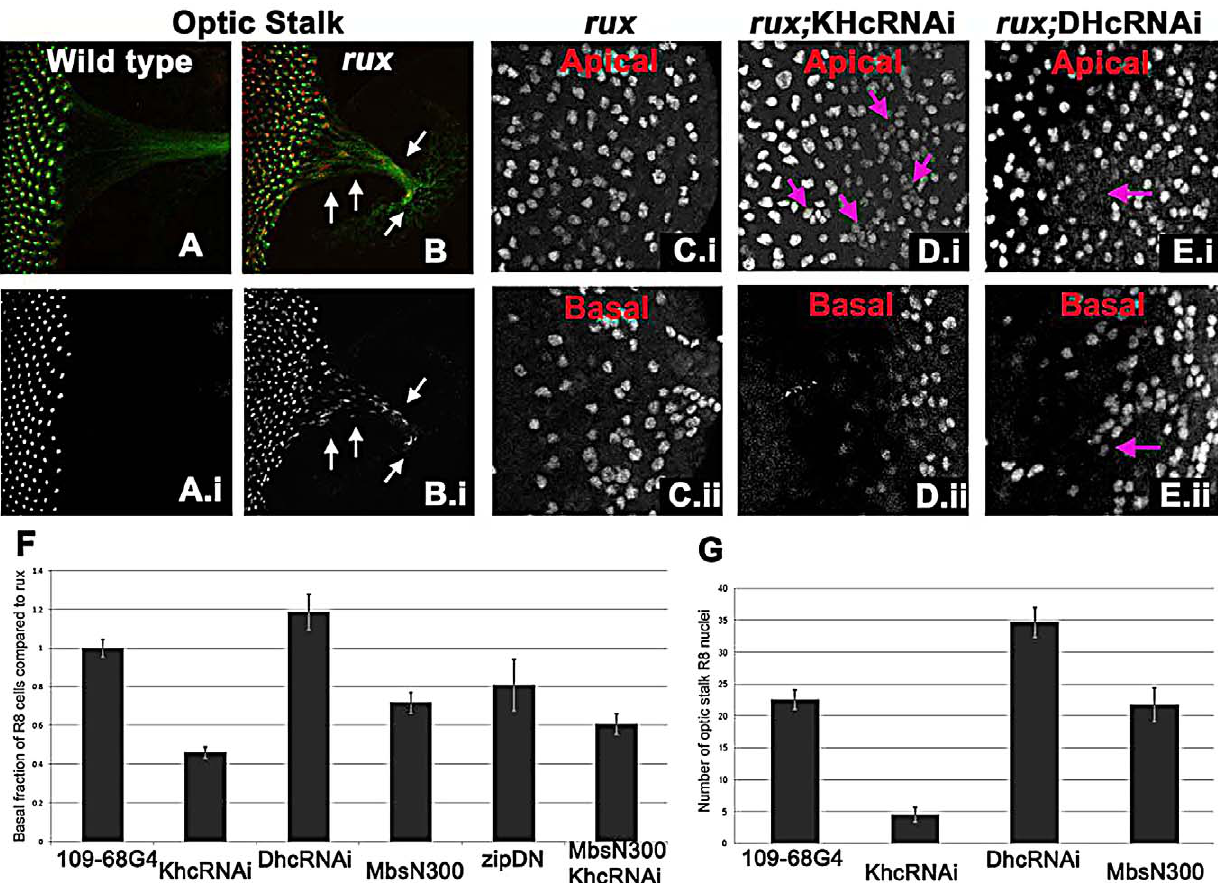
Figure 5. Kinesin and Dynein regulate nuclear position in post mitotic rux R8 cells. (A–B) Wild type (A) and rux (B) eye discs and optic stalks labeled with anti-Sens (red) and anti-Futsch (mAb22C10; green). Arrows showing R8 cells in the optic stalk in rux . (C) R8 cells from the apical (i) and basal (ii) portions of rux eye discs expressing GFP. (D) Coexpressing dsRNA for KHC retains R8 nuclei apically (i) while fewer drop basally (ii). Arrows indicate clusters of R8 nuclei apically. (E) Coexpressing dsRNA for DHC leads to apical regions lacking R8 nuclei (arrow in (i) while R8 nuclei accumulate basally (arrow in ii). (F). Results are quantified as the percentage of R8 nuclei observed in the bottom third of the eye disc (in all cases n . 2000, from at least 5 different eye discs) and have been normalized to rux alone (35%). bars indicate standard errors. (G) The average number of R8 nuclei identified in the optic stalk of rux mutants, and discs expressing inhibitors of molecular motors under the control of G109-68-Gal4 (n . 5 in all cases, bars indicate standard error).